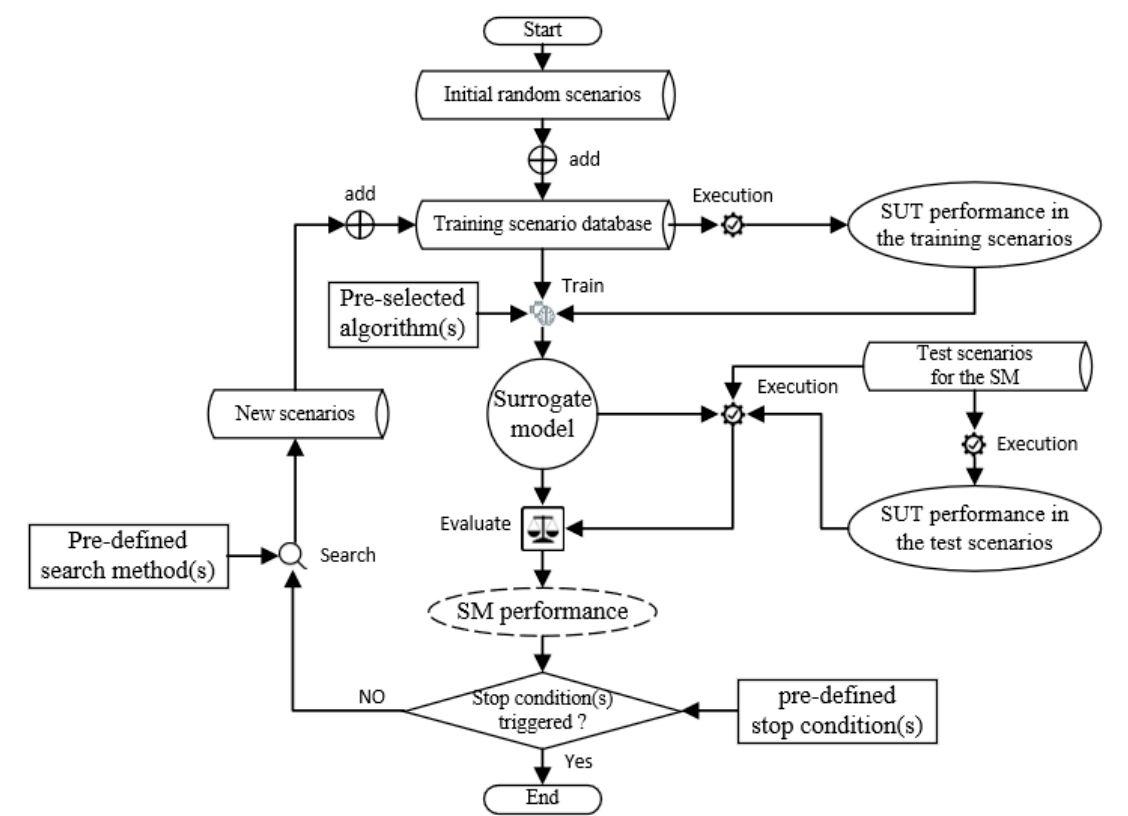
Figure 8. A schematic diagram for SM optimization.